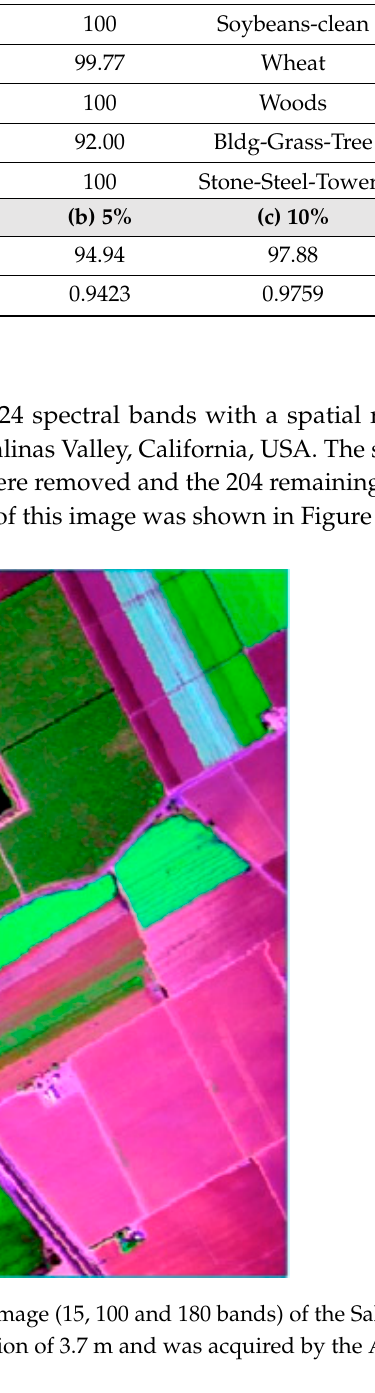
Table 4. Type of classes and their respective labeled pixels number in the Salinas dataset.